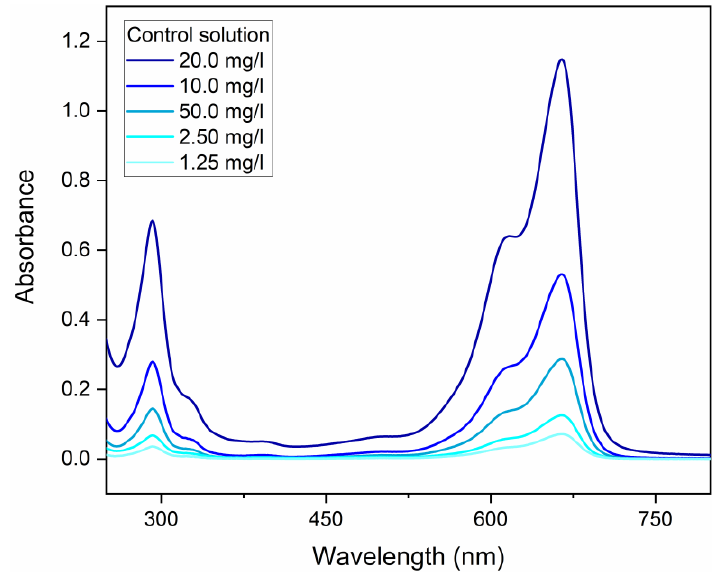
Figure 8. Absorbance of solutions in different concentrations. Materials 2020 , 13 , x FOR PEER REVIEW